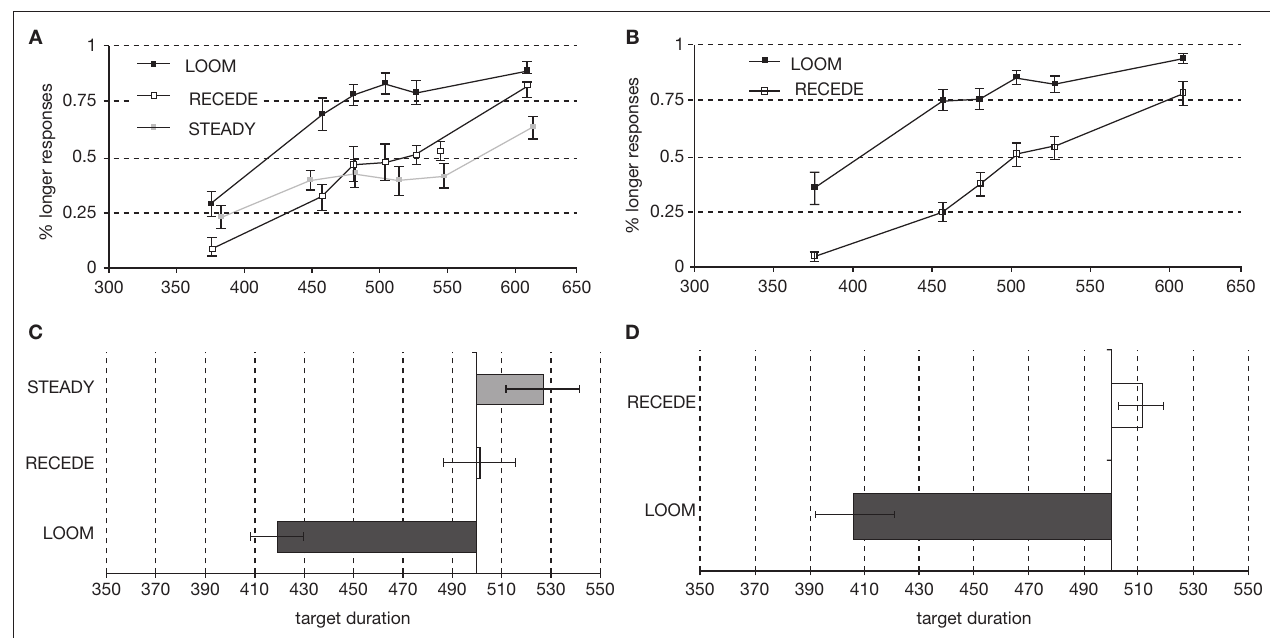
FIguRe 2 | Psychophysical results in the pre-fMRI session (left column) and in the fMRI session (right column): Percent longer responses [(A) pre-fMRI; (B) fMRI], points of subjective equality [PSe; (C) pre-fMRI; (D)